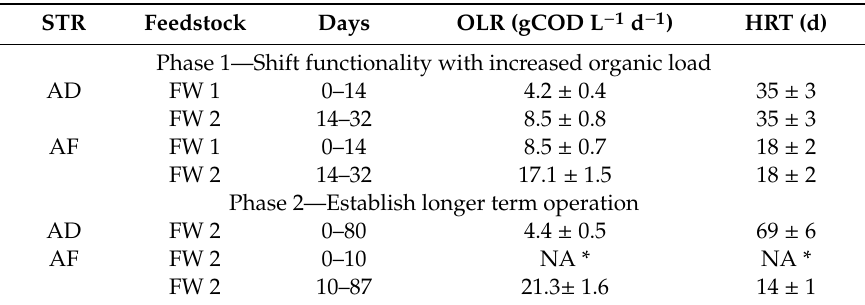
Table 2. Overview of operational parameters for the AD and AF